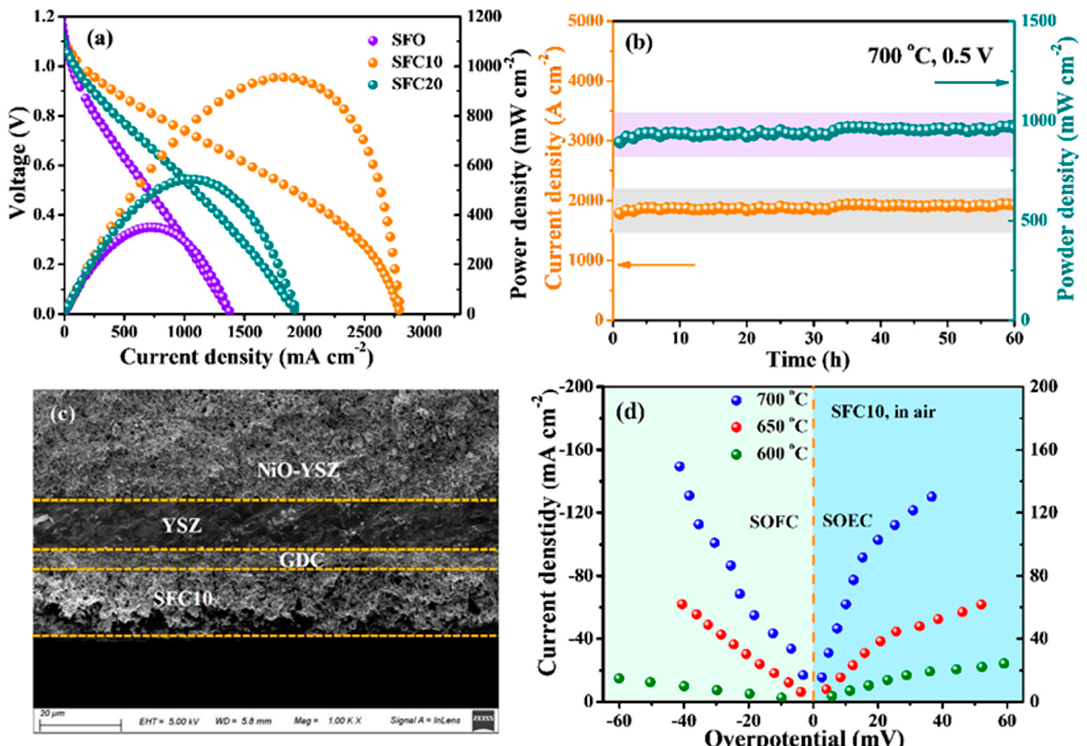
Figure 8. ( a ) I - V and I - P plots of the button cells NiO/YSZ|YSZ|GDC|SFC x at 700 °C; ( b ) cathode-based fuel cell at 700 ◦ C; ( c ) cross-sectional SEM image of the fuel cell; ( d ) the polarization plots of SFC10 electrode short-term durability of SFC10 cathode-based fuel cell at 700 °C; ( c ) cross-sectional SEM image of in SOFC and SOEC modes at various the fuel cell; ( d ) the polarization plots of SFC10 electrode in SOFC and SOEC modes at various temperatures.